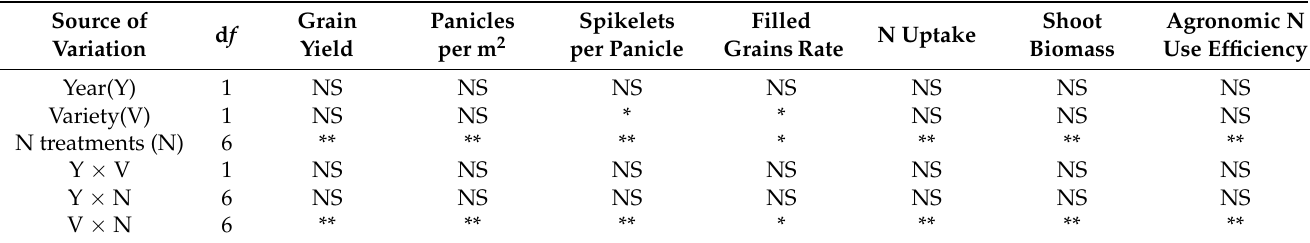
Table 2. Analysis-of-variance of F-values of grain yield, yield components, N uptake, shoot biomass and agronomic N use efficiency among years, varieties, and N reduction treatments.